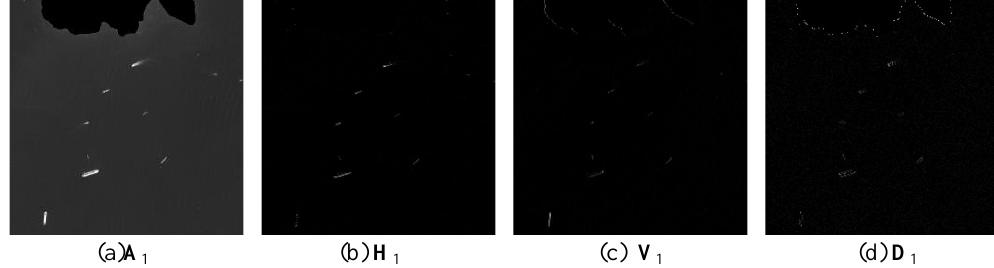
Figure 5. The decomposition result of Figure 4f based on DWT. ( a ) A 1 denotes the approximation; ( b ) H 1 denotes the horizontal detail image; ( c ) V 1 denotes the vertical low-pass detail image; ( d ) D 1 denotes the diagonal detail